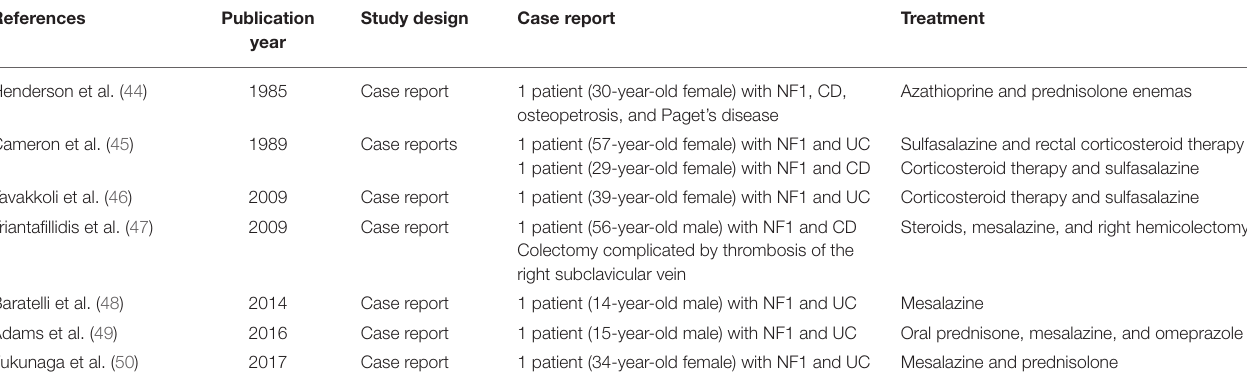
TABLE 5 | Characteristics and main results of studies on NF1 and